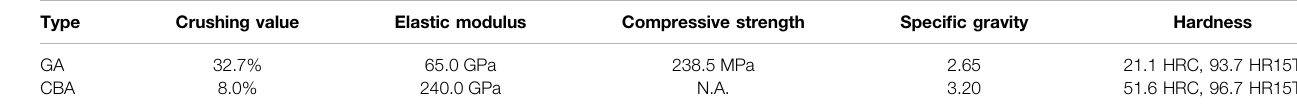
TABLE 1 | Physical and mechanical properties of GA and CBA.